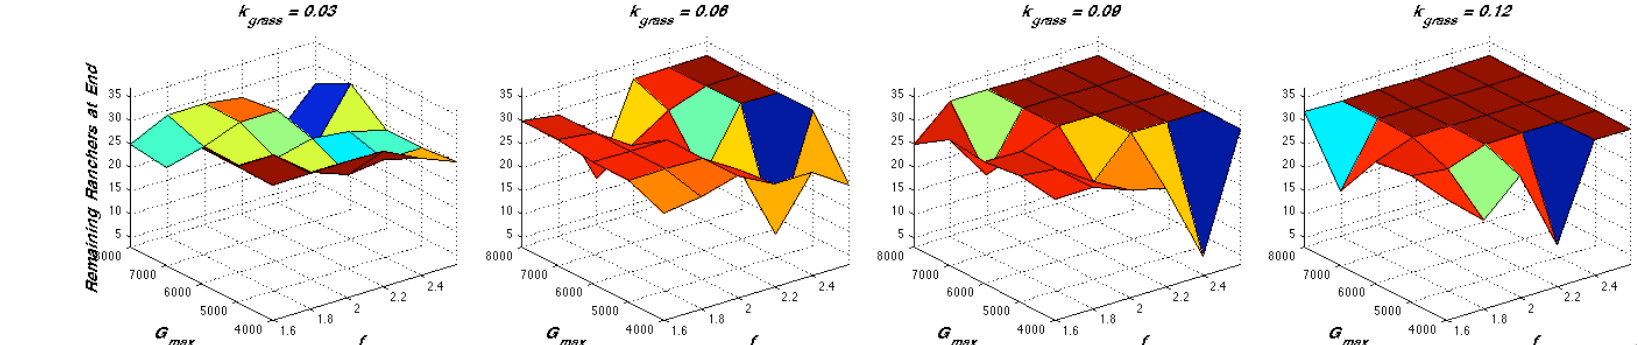
Figure A2.6: Number of ranchers remaining at end of simulation across dimensions of grass capacity G maximum intrinsic grass growth rate k (/t). Individual surfaces show number of ranchers as a function of grass capacity and stocking factor f at a grass constant intrinsic grass growth rate.